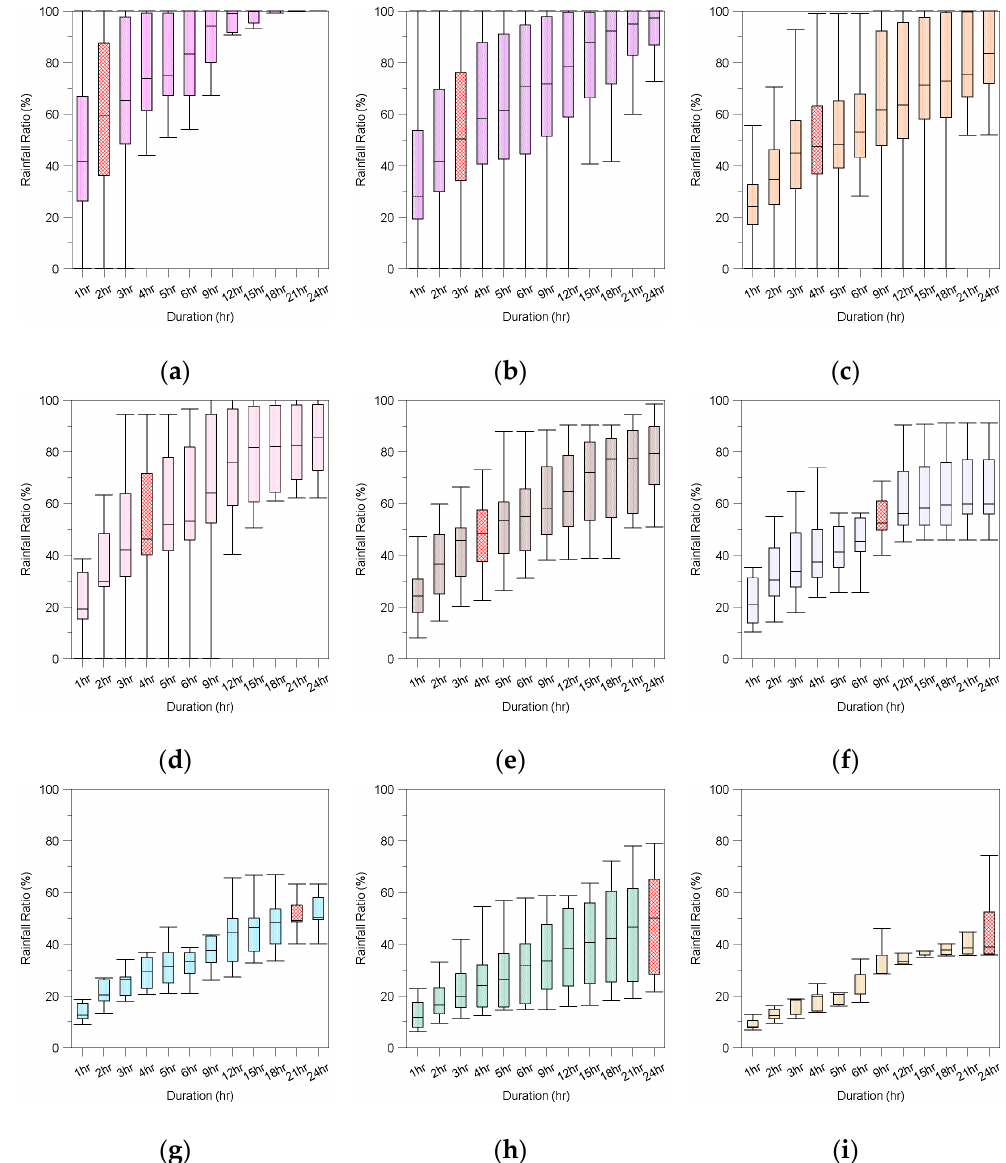
Figure 7. Ratio of rainfall to total rainfall by duration according to length of disaster occurrence period: ( a ) 1-day; ( b ) 2-day; ( c ) 3-day; ( d ) 4-day; ( e ) 5-day; ( f ) 6-day; ( g ) 7-day; ( h ) 10-day; and ( i )